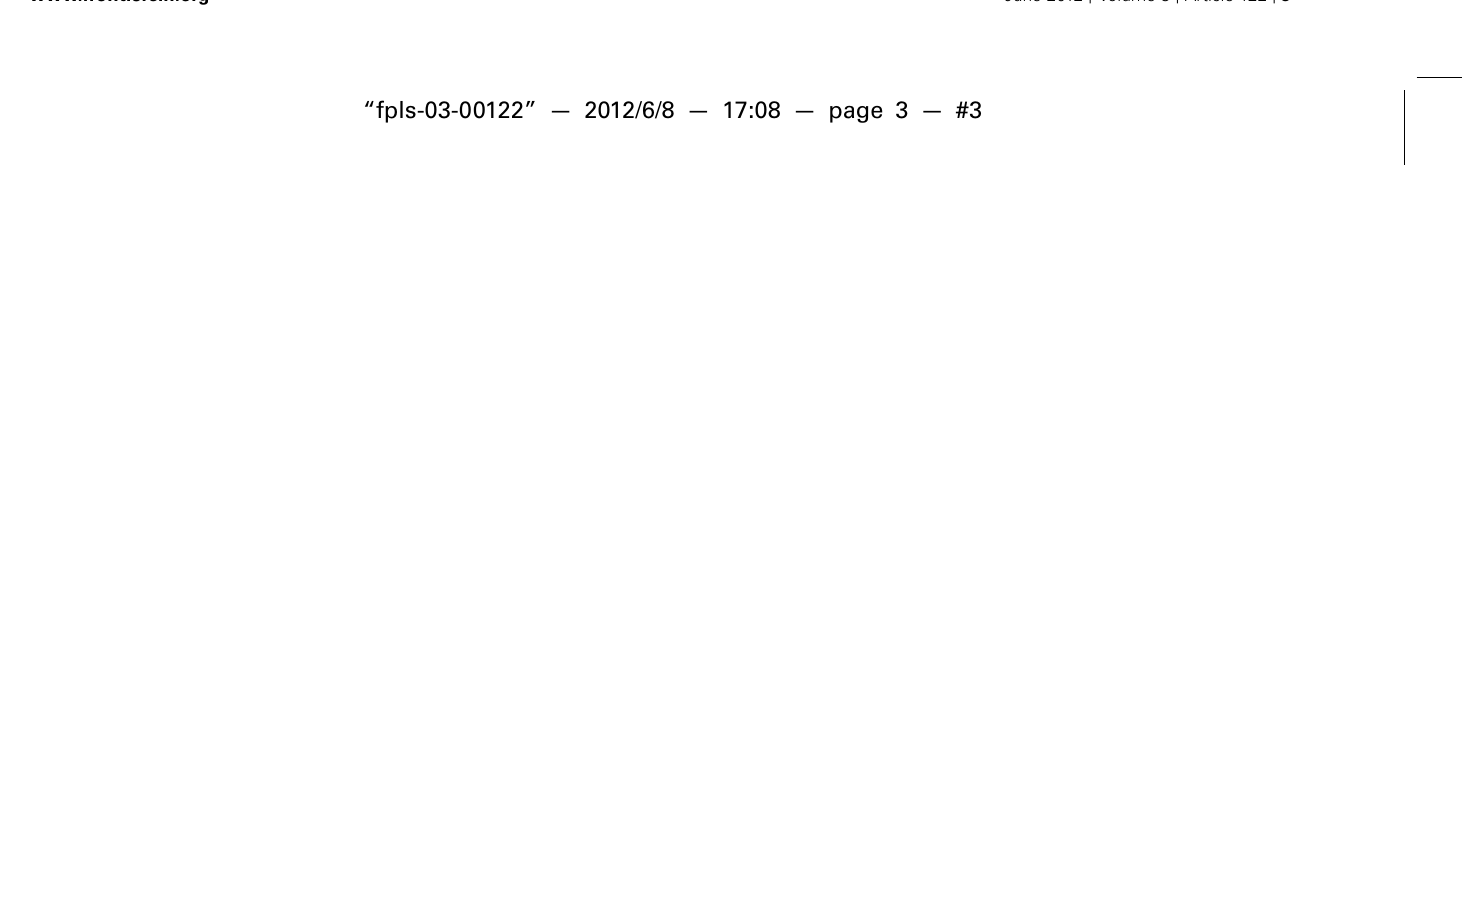
FIGURE 2 | Homepage and search page of the Medicago PhosphoProtein Database. (A) The MPPD homepage contains a description of the database as well as instructions on how to search the database. (B) Search result for the protein, Interacting Protein of DMI3 (IPD3). A protein description search returned results listing the protein description, protein coverage, sequence redundancy, number of protein groups, number of proteins and peptides within a protein group, and the protein group p -score. Modified amino acids are displayed in lowercase with green and red letters representing localized